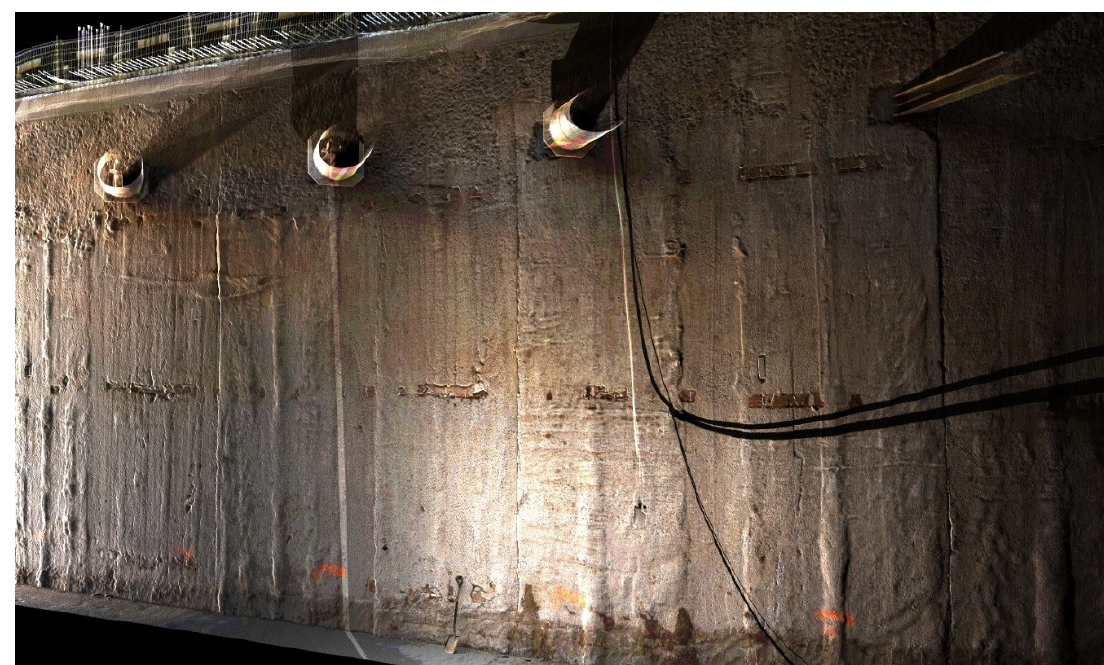
Figure 7. View of the point cloud (in the RGB color space) of northern diaphragm wall. For each geotechnical layer, eight samples of 1 × 1 m dimensions were cut out from the point cloud representing the surface of the excavated diaphragm wall in convenient places (Figure 8). Samples marked in red come from anthropogenic soil (Mg), samples marked in blue from medium sand (MSa), and samples marked in green from sandy gravel (grSa) layer. The sample designation consisted of a symbol describing the geotechnical layer and the sequence number of the sample within the layer, numbered from right to left (Figure 8).